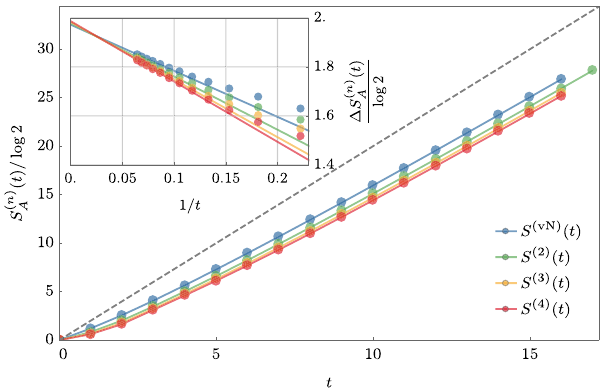
FIG. 10. The second R´enyi entropy for a kicked Ising system evolving from “ tilted ” initial states (12) in the thermodynamic limit. The colored lines correspond to nonseparating initial states (we take ϕ ¼ θ , with θ and h specified in the legend) and are determined numerically evaluating Eq. (98), while the gray dashed lines report, for comparison, the result from separating states. The inset shows the instantaneous slope Δ S ð [cf. Eq. (100)] as a function of 1 =t . The points are computed by evaluating Eq. (98), while the lines are a linear fit of the last two points.